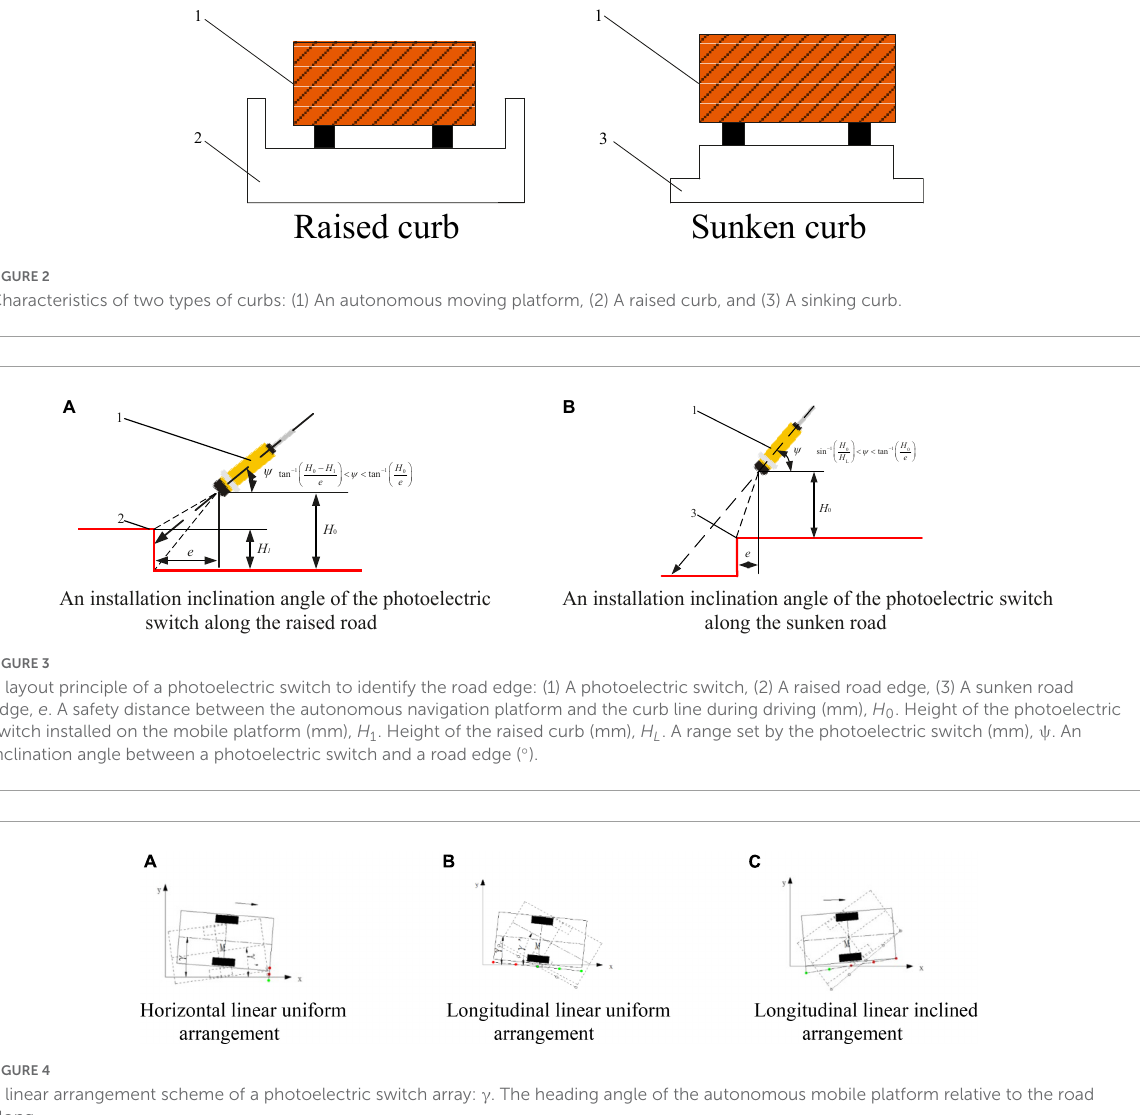
directly obtained from the current state of the photoelectric switch group. The information can only be obtained from the installation position of the photoelectric switch group, the time of state change before and after the photoelectric switch group, and the motion state of the mobile platform, and then